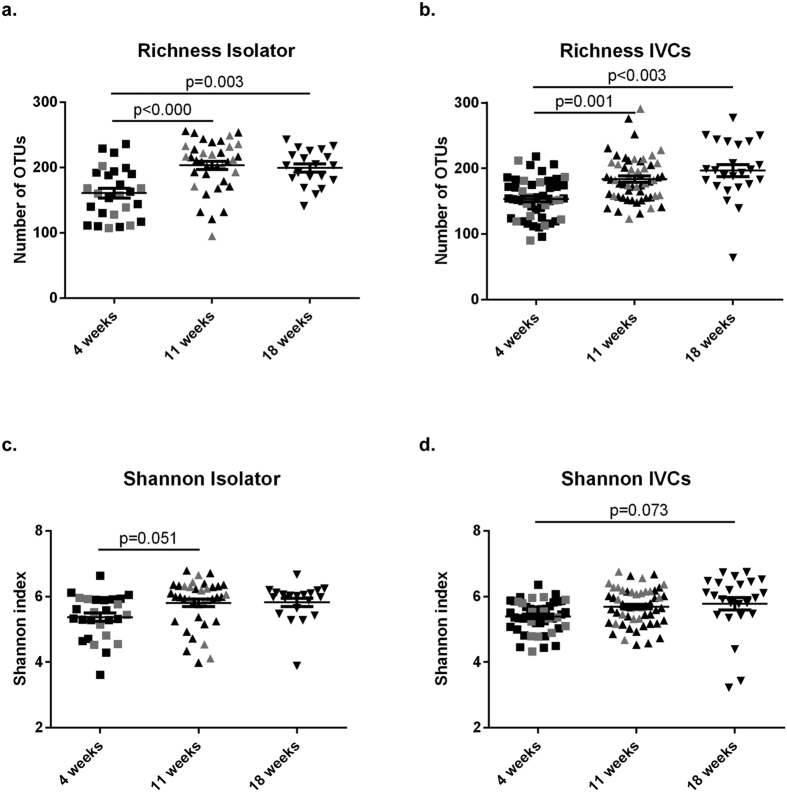
Alpha diversity of the gut microbiota at different ages.Richness (a+b) and Shannon index (c+d) of fecal samples from F1 and F2 mice aged 4, 11, and 18 weeks. The 4 and 11 week age time points represent cumulated samples from F1 (black symbols) and F2 (grey symbols), as these were not statistically different. 18 weeks represent F1 only, as the study did not include F2 mice aged 18 weeks (ANOVA with Tukey’s pairwise comparisons; bars are s.e.m.).